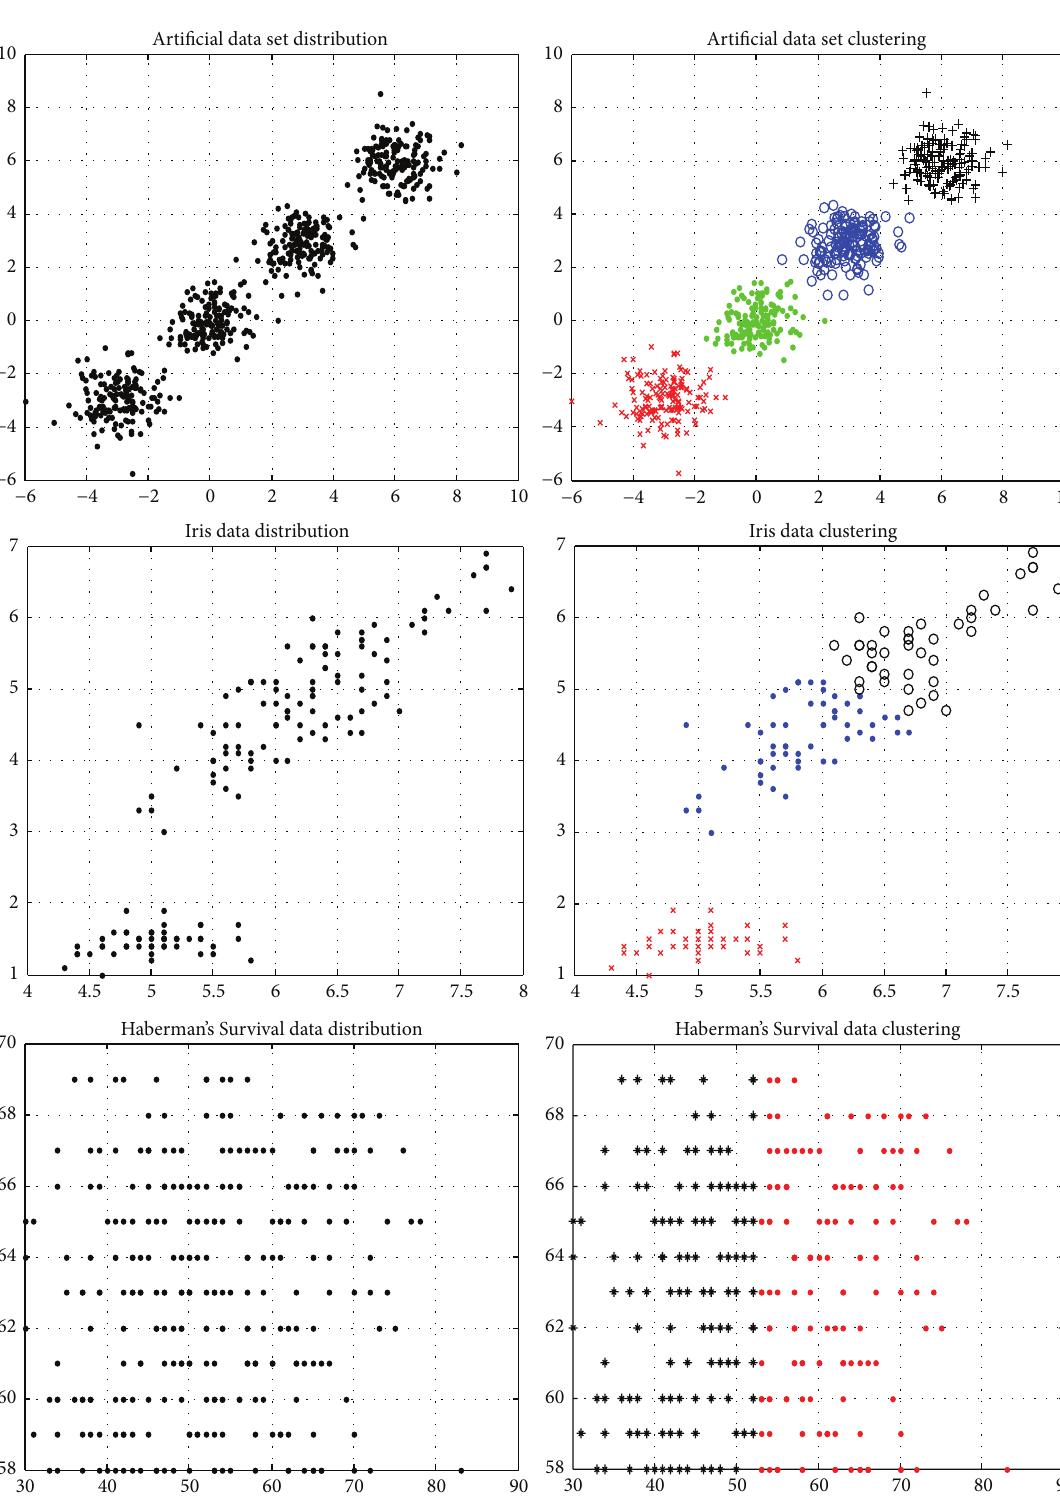
Figure 4: The original data distribution of Art, Iris, and Survival data sets and the clustering results by PGWO